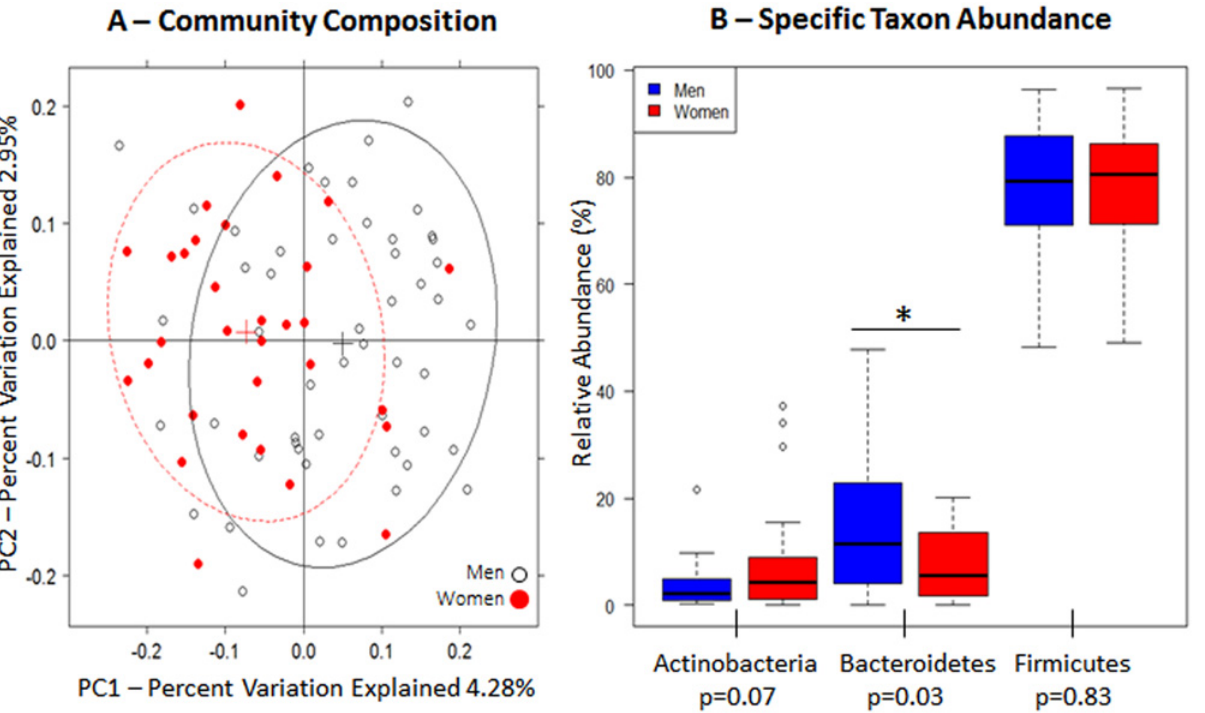
Fig 1. Gut microbiome according to sex. (A) Unweighted principal coordinate analysis plot of the first two principal coordinates categorized by sex. Ellipses were added to plots using the R package, latticeExtra (R version 2.15.3). (B) Relative abundance of the three major phyla. Mann-Whitney-Wilcoxon test was used to test for overall differences using SAS software (version 9.3). Nominal p-values are listed below each